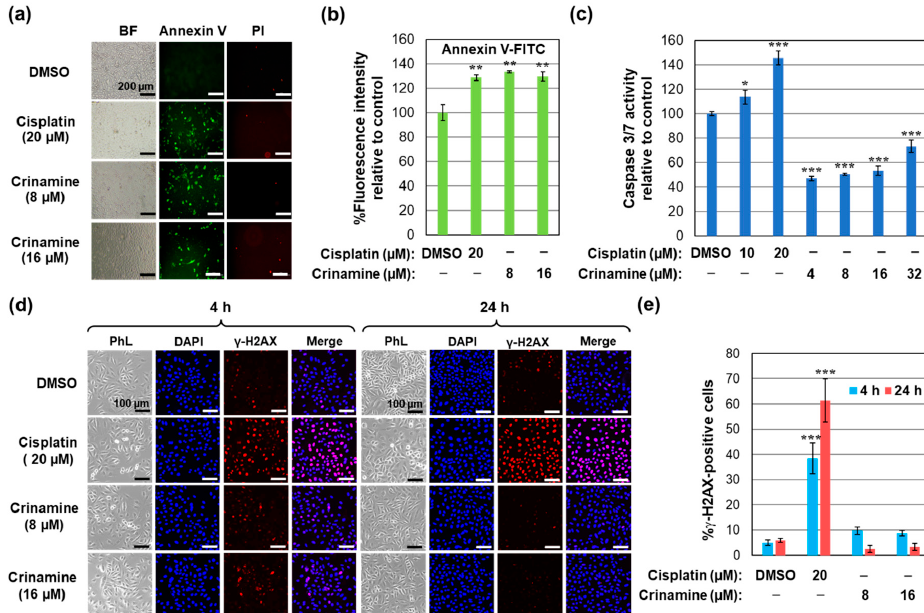
Figure 3. Crinamine-mediated apoptosis activation in cervical cancer cells. ( a ) Annexin V and PI staining of SiHa cells treated with cisplatin, crinamine, or DMSO for 16 h. ( b ) Fluorescent intensity of Annexin V staining from ( a ); results are shown as means ± SD from triplicate measurements. ( c ) Caspase-3 / 7 activity of crinamine in SiHa cells non-treated or treated with the indicated concentrations of cisplatin or crinamine for 24 h. Caspase activity is normalized to the DMSO control and is reported as means ± SD from triplicate experiments. ( d ) Immunofluorescence staining of histone γ -H2AX in SiHa cells treated with the indicated concentrations of cisplatin, crinamine, or DMSO for 4 and 24 h. Panels represent phase contrast (PhL) images, DAPI nuclear staining (blue), γ -H2AX foci (red), and merged images. ( e ) Percentage of γ -H2AX foci-positive cells quantified from five fields per treatment obtained from duplicate measurements. Results are representative of data observed on two separate